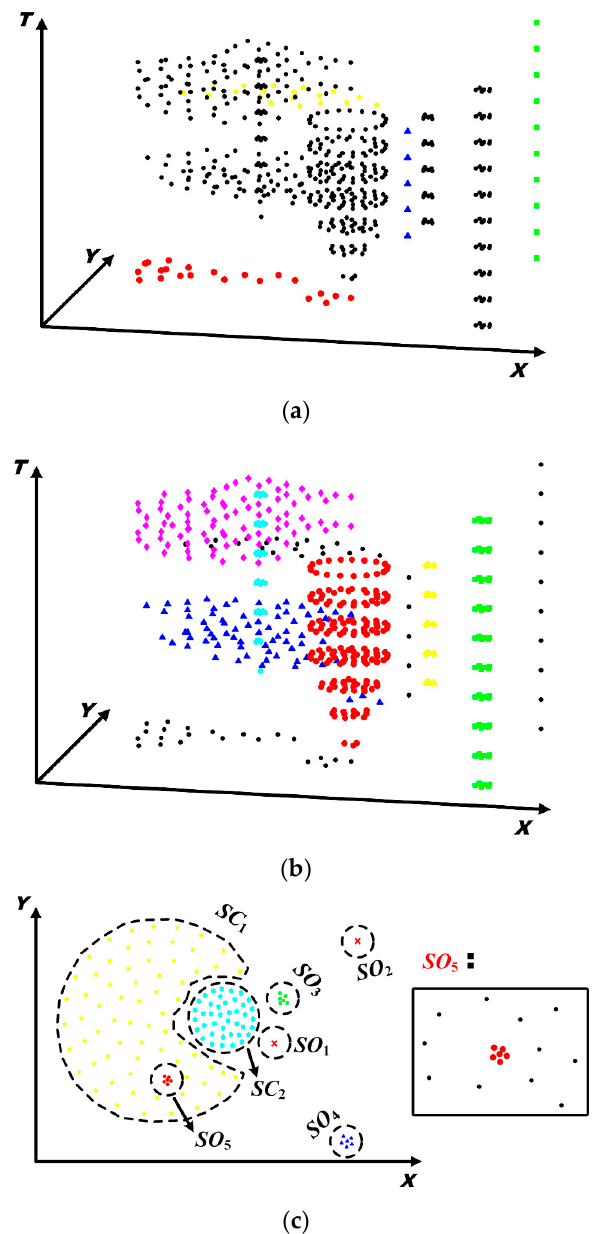
Figure 8. Evolving spatio-temporal patterns of STTE and spatial distribution patterns of STE . ( a ) Spatio-temporal outliers; ( b ) Spatio-temporal clusters; ( c ) the spatial distribution patterns of STE . In each figure, different symbols represent different STO or STC except for black points.